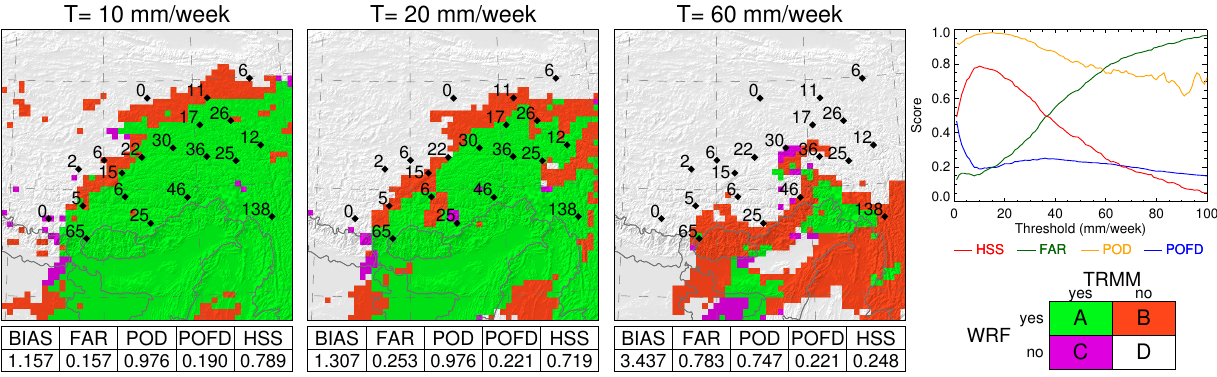
Fig. 5. Left: Spatial patterns of the contingency tables for three different thresholds (10, 20 and 60 mmweek − 1 ) applied to the one-week precipitation of WRF30–MD and TRMM, together with values from ground observations at the weather stations. Right: WRF30–MD scores with respect to TRMM for the threshold range from 1 to 100 mmweek − 1 .